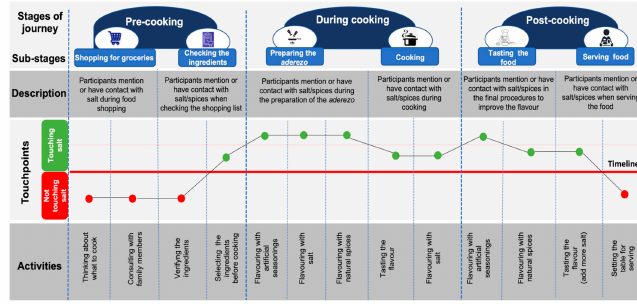
Figure 1. Participants’ composite customer journey